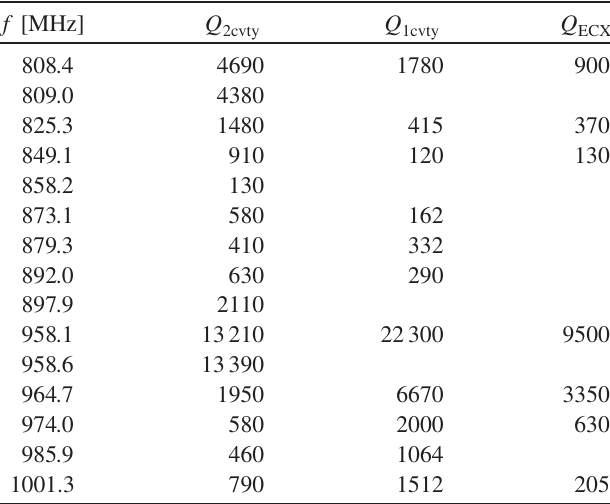
TABLE V. Parameters of ferrite-damped HOMs for the two- cavity string.